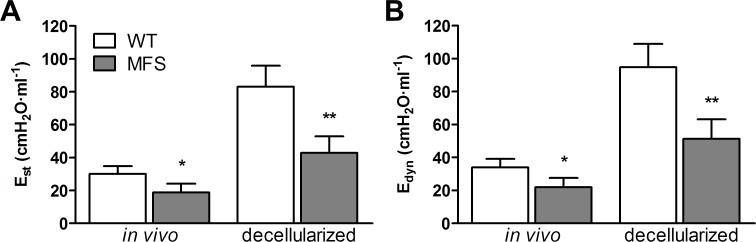
Lung elastances before and after decellularization.(A) Static (Est) and (B) dynamic (Edyn) elastances in WT (white column) and Marfan mice (MFS; grey column) determined by the end-inspiratory airway occlusion method in vivo and in the acellular lung scaffolds after organ decellularization. Data are mean ± SE. *: p < 0.05; **: p < 0.01.